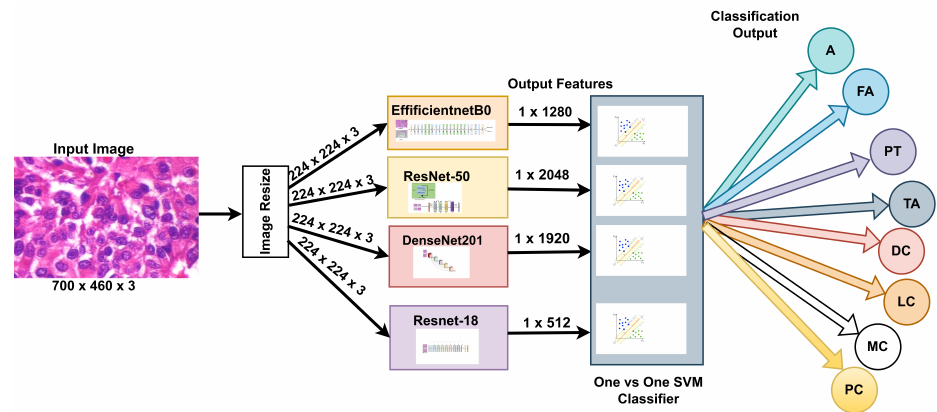
Figure 12. Computational process architecture for the ensemble